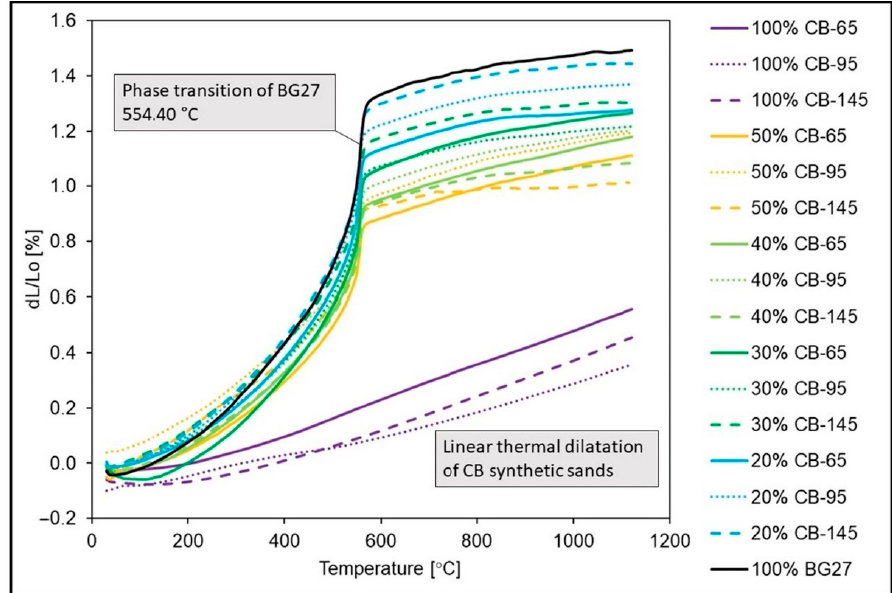
Figure 3. Dilatation curves for hybrid sands and reference samples of 100% pure sands .